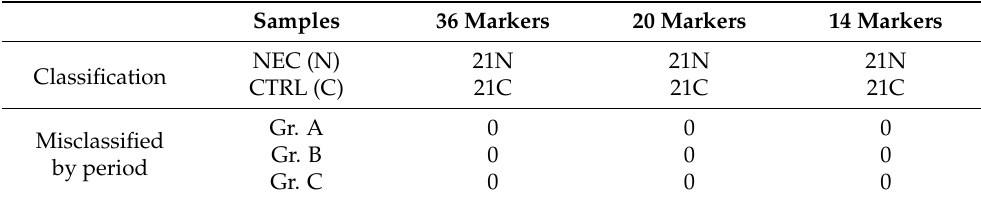
Table 3. Clustering and classification analysis.